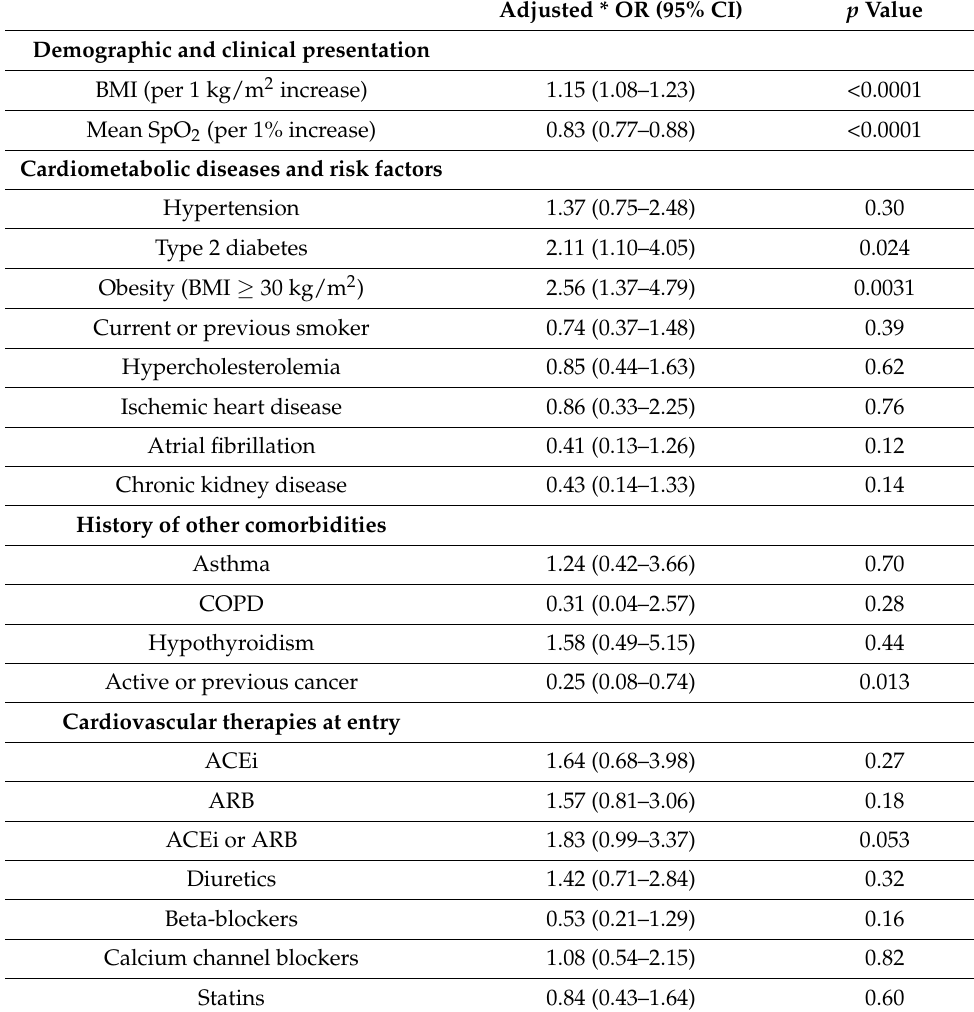
Table 2. Risk factors of COVID-19 severity among hospitalized patients with COVID-19 as deter- mined from the need for ICU